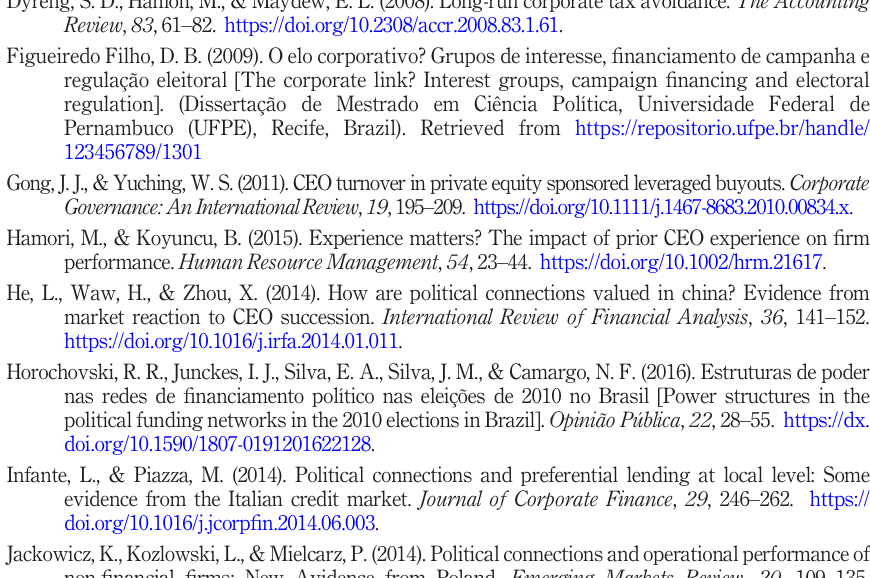
Figueiredo Filho, D. B. (2009). O elo corporativo? Grupos de interesse, fi nanciamento de campanha e regulação eleitoral [The corporate link? Interest groups, campaign fi nancing and